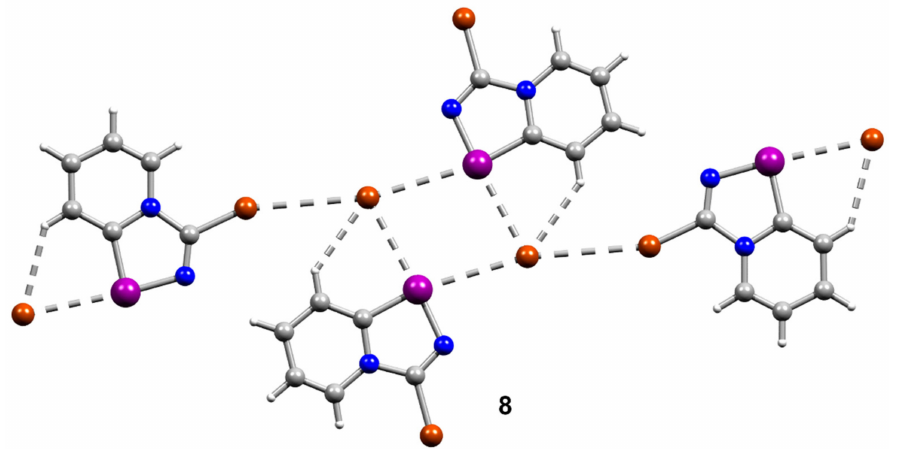
Figure 5. Ball-and-stick representation of the crystal structure of 8 , demonstrating its self-assembly into 1-D supramolecular polymer via Se ··· Br and Br ··· Br interactions. Brown, purple, blue, grey, and light-grey spheres represent bromine, selenium, nitrogen, carbon, and hydrogen, respectively.